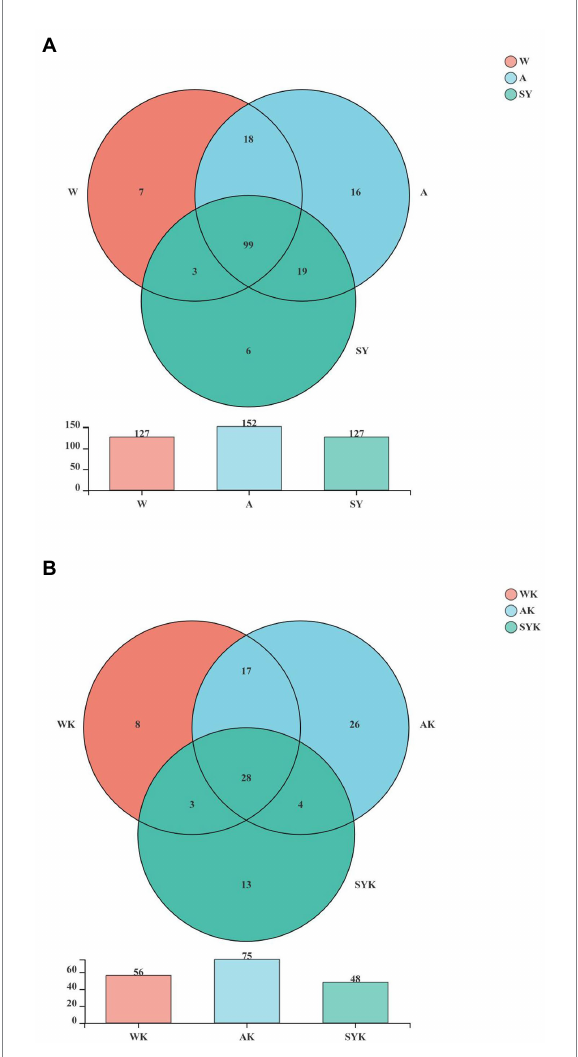
FIGURE 2 Venn analysis of shared and unique microbial OTUs of raw materials and ryegrass silages. (A) Raw materials; (B) Ryegrass silages. W, Raw materials of Ordos-wushenqi; A, Raw materials of Hohhot; SY, Raw materials of Ulanqab-siziwangqi; WK, Ryegrass silages of Ordos-wushenqi; AK, Ryegrass silages of Hohhot; SYK, Ryegrass silages of